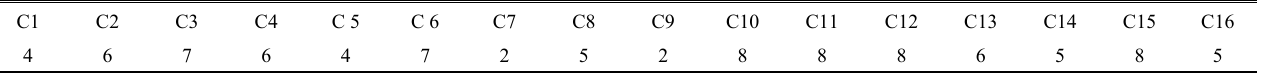
Table 2. Subspace dimension of each class (see Table 1) with a fidelity value of 0.99986.